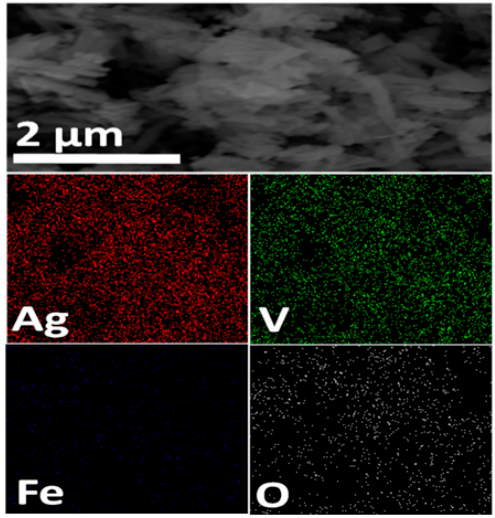
Figure 6. Element mapping images of the optimized FeAVO-3 nanocomposite photocatalyst.